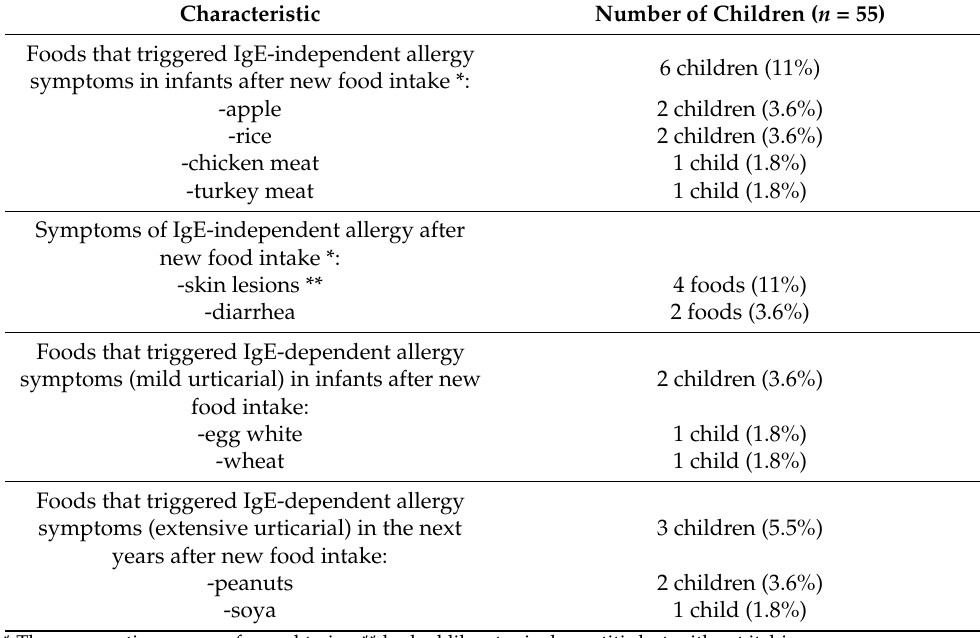
Table 3. Symptoms of allergy to new foods introduced into the diet in the study group of children with chronic food protein-induced enterocolitis syndrome (FPIES) dependent on cow’s milk protein intake. Characteristic Number of Children ( n = 55) Foods that triggered IgE-independent allergy symptoms in infants after new food intake *: